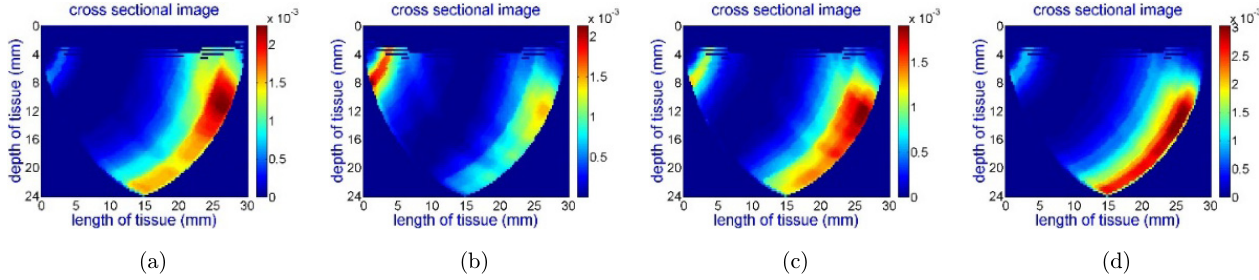
Fig. 10. Case study #1: reconstructed images from collected data using the DOB-Scan probe in four wavelengths ((a) 690 nm, (b) 750 nm, (c) 800 nm and (d) 850 nm), left breast, cancerous lesion located at 10 o'clock position and 54 mm away from the